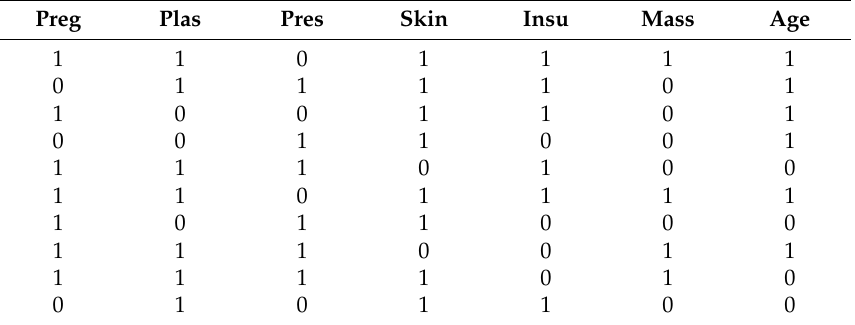
Table 18. Applying Restrict Mutate on the Chromosome set in the last generation.